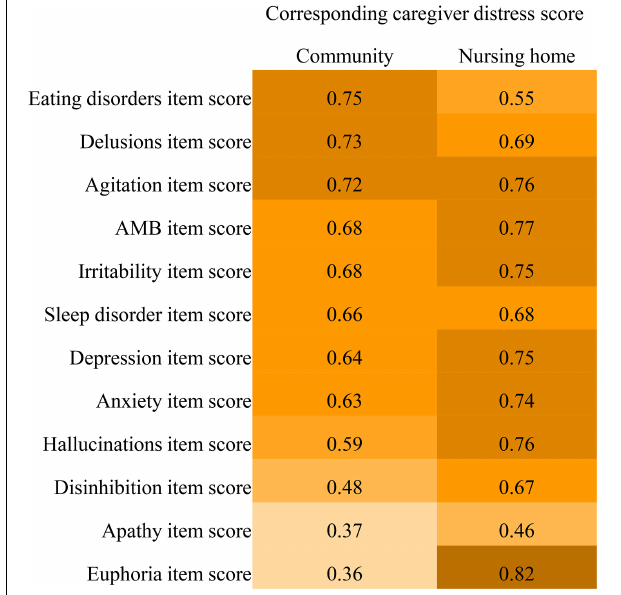
FIGURE 2 | Comparisons of R 2 values of the Neuropsychiatric Inventory item scores predicting caregiver distress between community-dwelling older adults with dementia and nursing home residents with dementia.